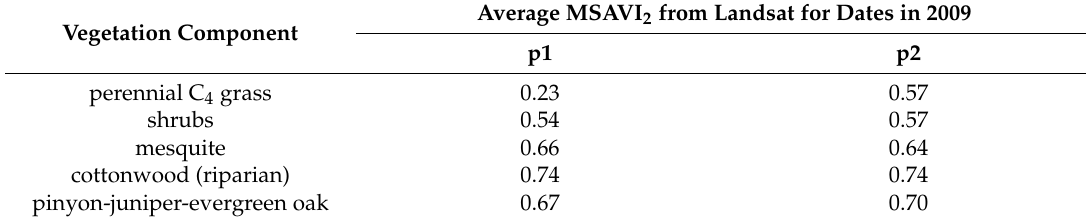
Table 2. Estimated values of MSAVI 2 for nominally pure samples of vegetation